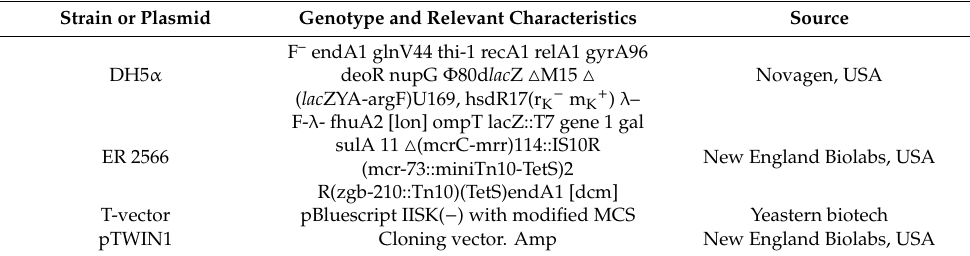
Table 4. E. coli strains used in this